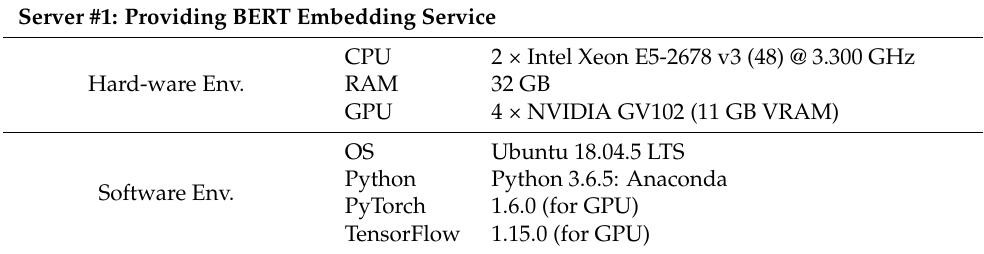
Table A2. Hardware and software environments of Server#2. Server #2: Main Experimental Environment Hard-ware